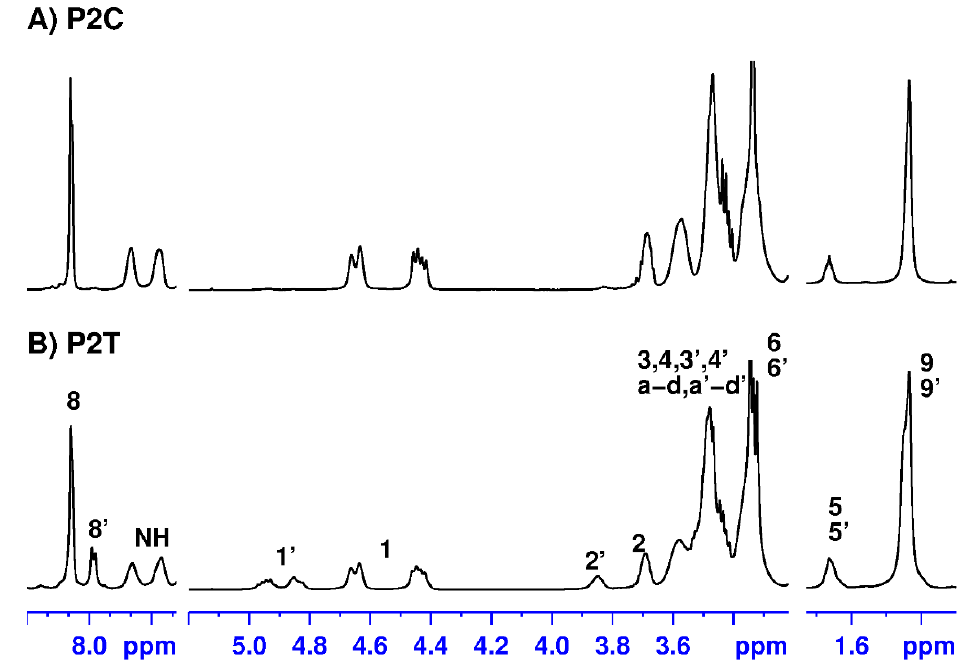
Figure 3. 1 H NMR spectra of polymers P2C and P2T recorded in deuterochloroform.